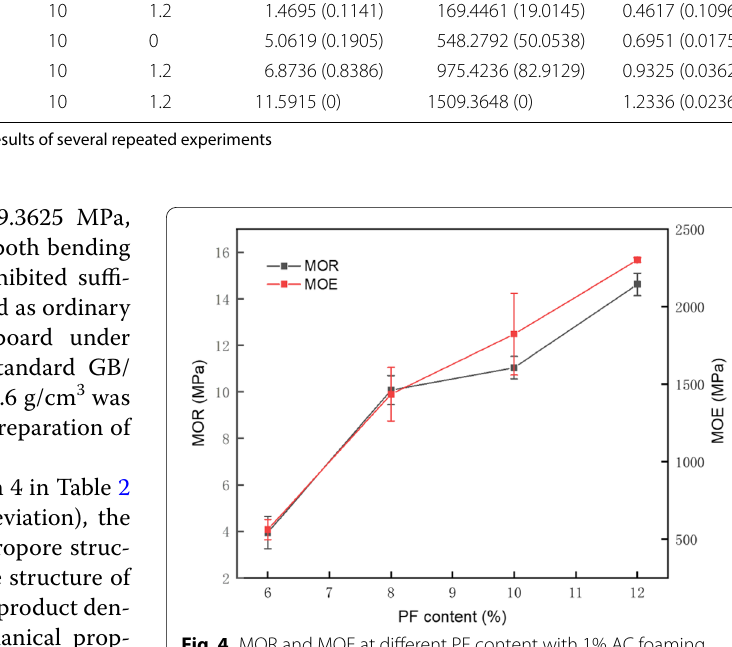
Fig. 4 MOR and MOE at different PF content with 1% AC foaming agents